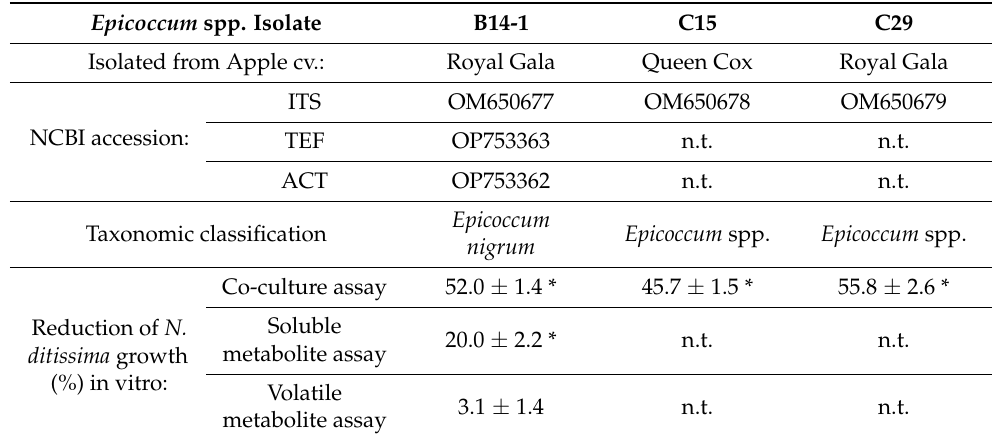
Table 1. Taxonomic and in vitro antagonism data of endophytic Epicoccum spp. strains isolated in this study. Mean growth reduction (%) v s. the control ± 1 SE is shown across three different N. ditissima isolates and two experiments, with 5–10 replicates per experiment. Isolates C15 and C29 were not tested (n.t.) in volatile and metabolite assays. Statistically significant ( p ( t -test) < 0.01) reduction of growth compared to the control is denoted with